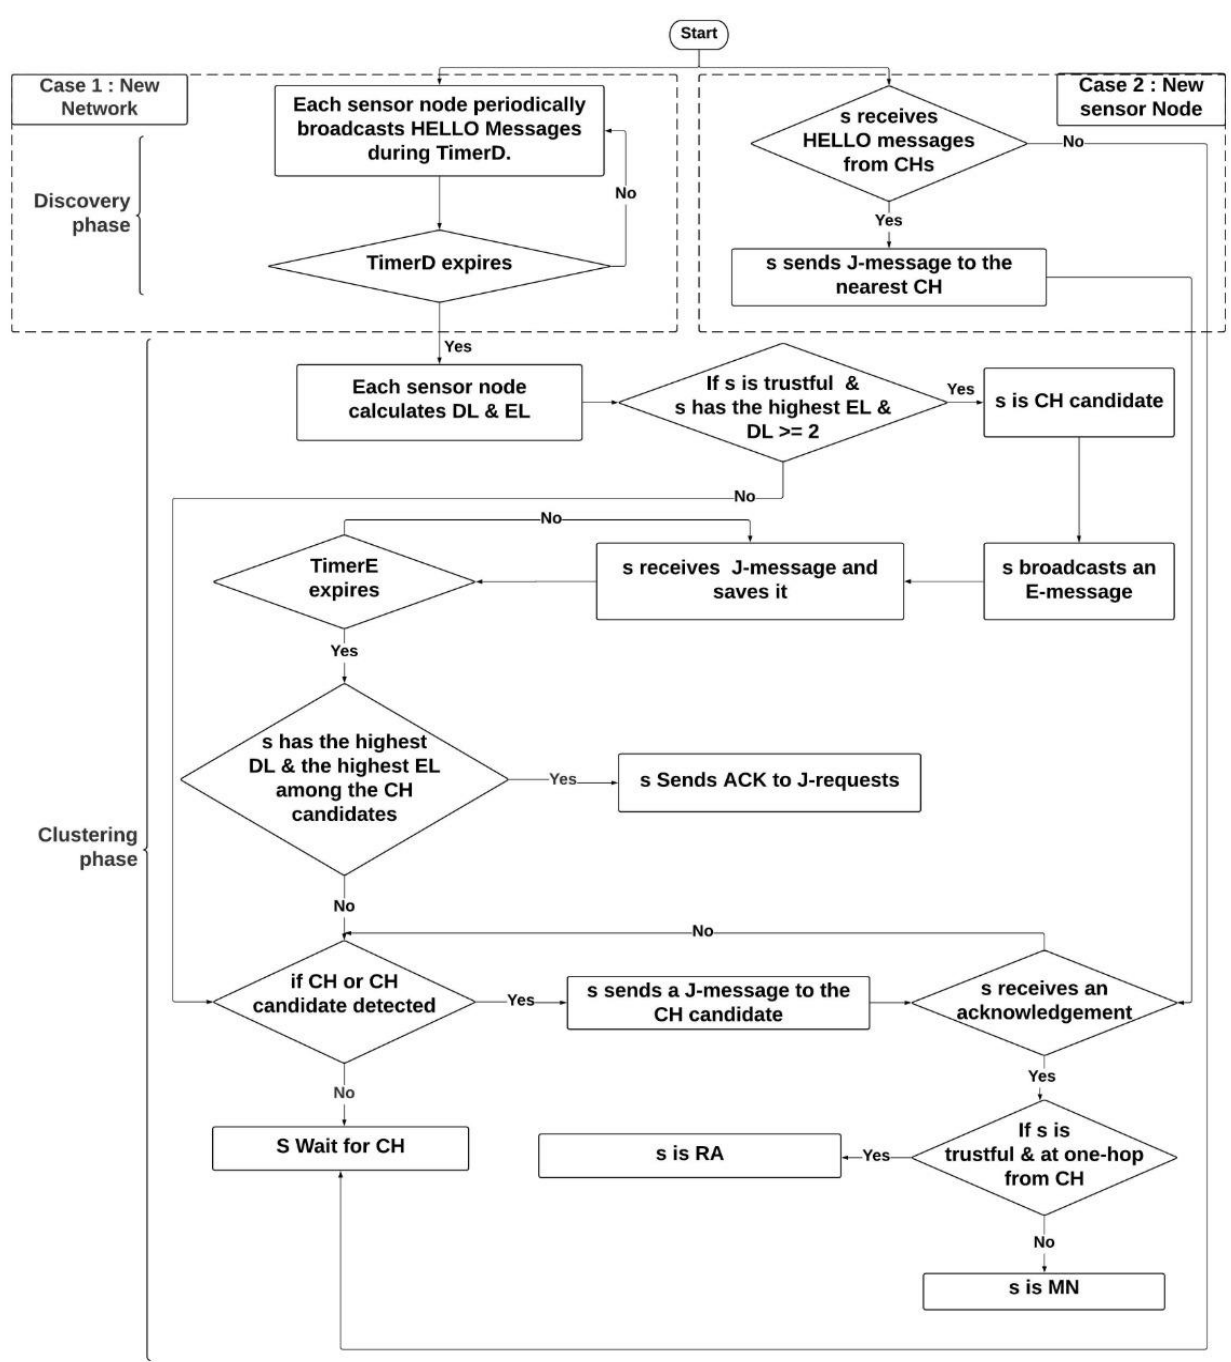
Figure 1. Flowchart of the proposed clustering algorithm.